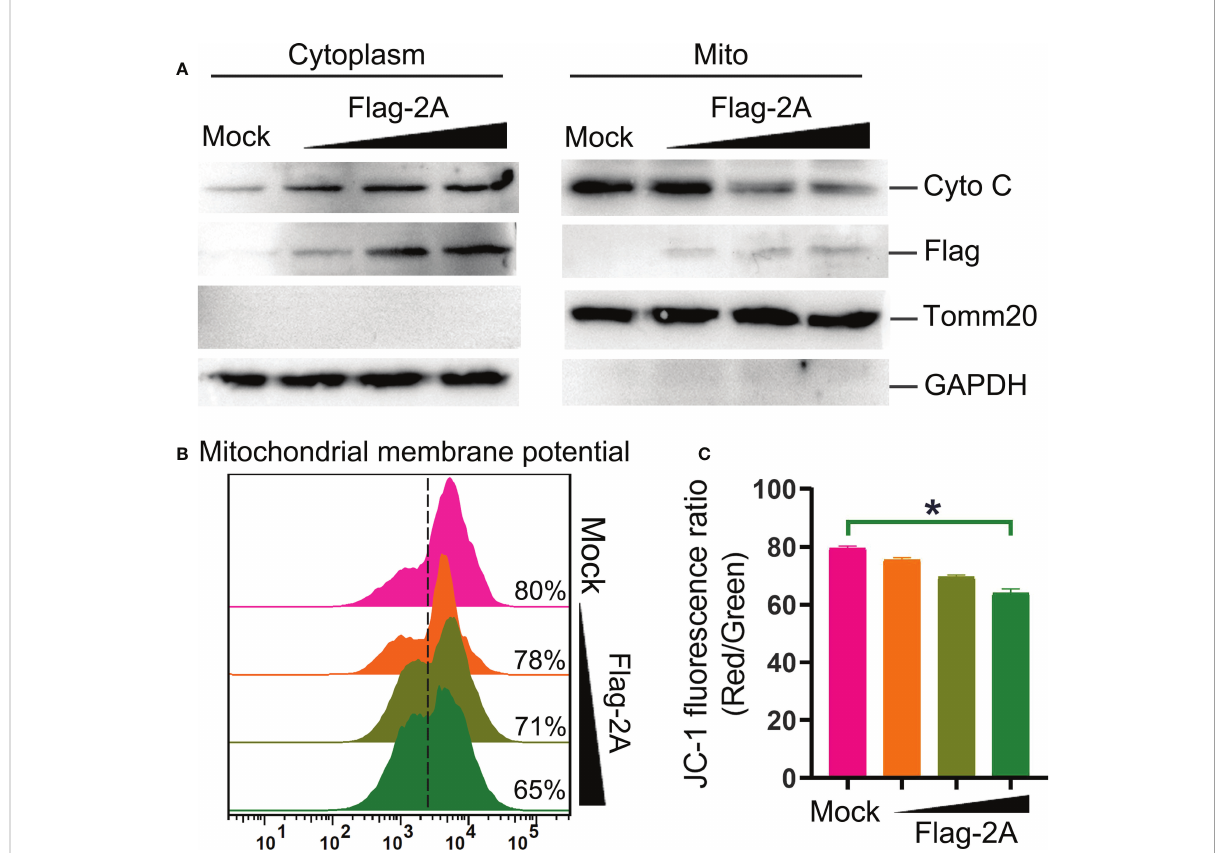
blot. (B, C) For detecting the mitochondrial membrane potential, the HEK293A cells were transfected with pCAGGS-Flag-2A for 24 h, the cells were labelled with JC-1 and detected through fl ow cytometry. The graph represents the JC-1 fl uorescence ratio (Red/Green). *P <